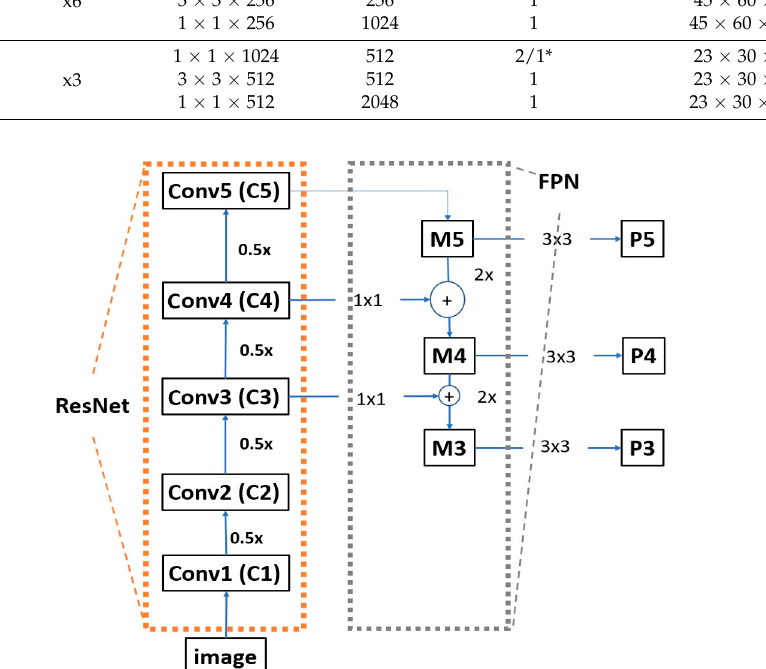
Figure 5. Architecture of deep RetinaNet with revised ResNet (block in orange box) and FPN (block in gray box). M3~5 means the feature maps obtained from Conv3~5, respectively, whereas P3~5 shows the feature maps for prediction.